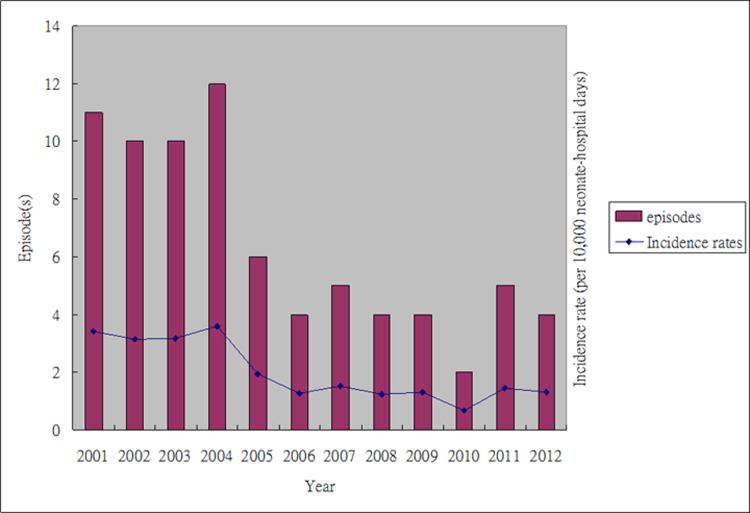
Bacteremia due to extended-spectrum β-lactamase (ESBL)-producing Enterobacteriaceae in the neonatal intensive care unit, 2001–2012, Episodes and clinical incidence rates per year.